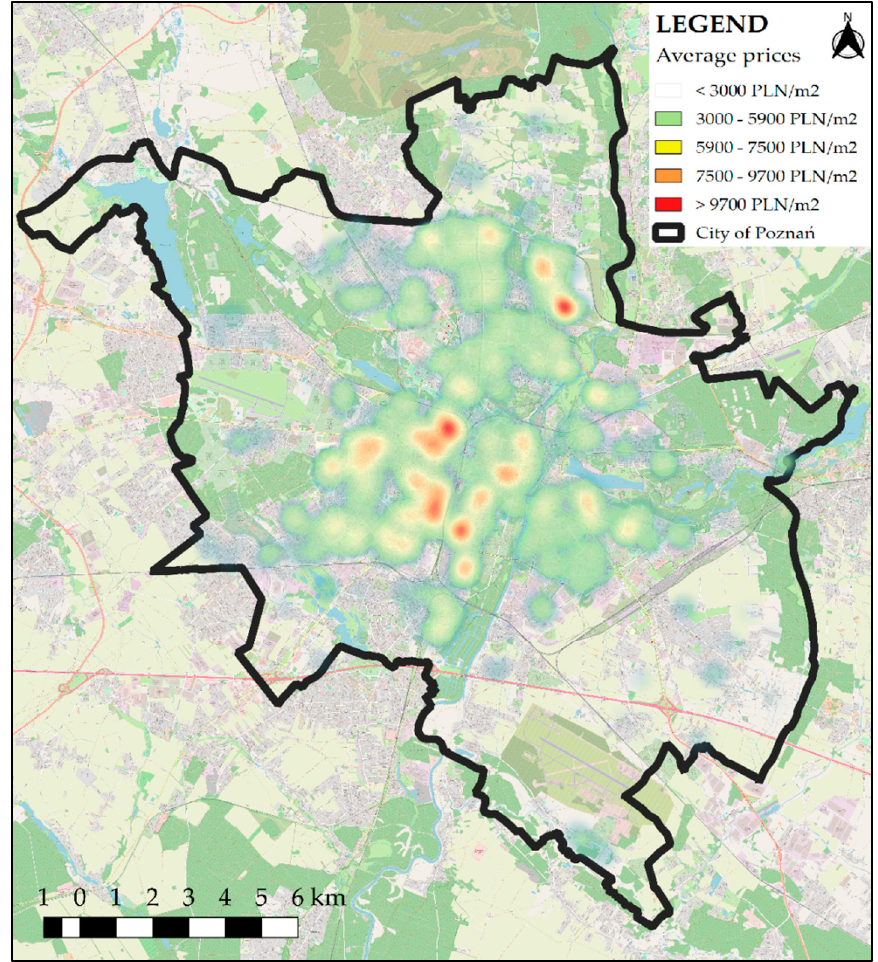
Figure 3. Interpolation of housing prices within the study area (kernel density estimation).